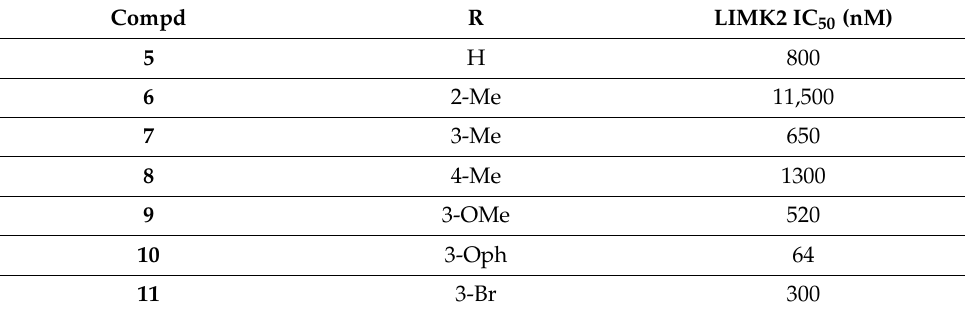
Table 1. Phenyl ring Substitution.